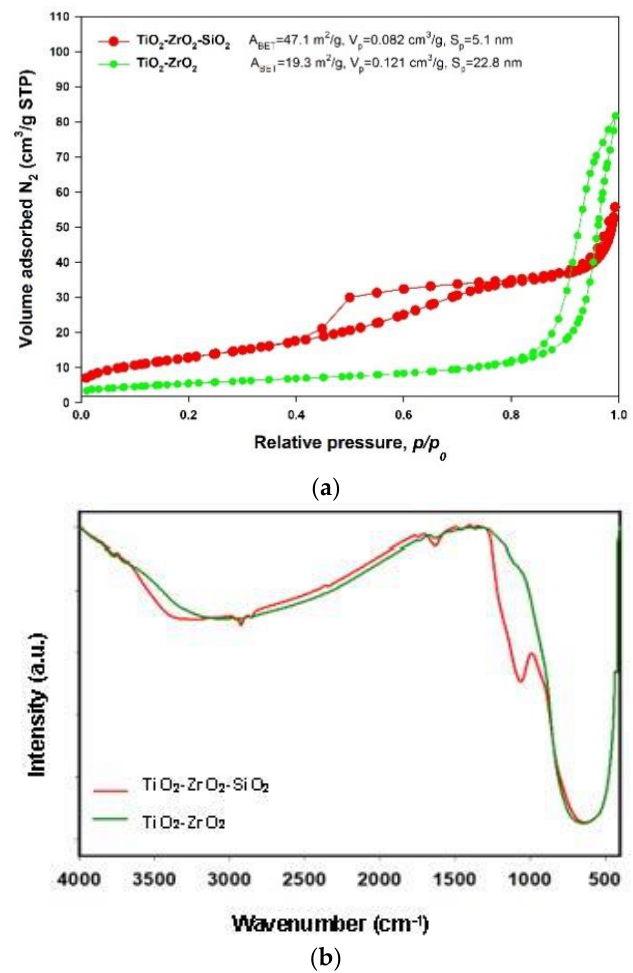
Figure 3. N 2 adsorption/desorption isotherms ( a ) and Fourier-transform infrared (FTIR) spectra ( b ) of the synthesized materials.